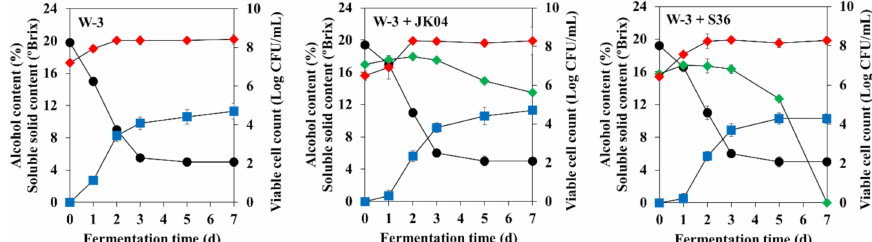
Figure 3. Soluble solids (black circles), alcohol contents (blue squares) and viable cell counts (diamonds) of Muscat Bailey A wine fermented by single culture of Saccharomyces cerevisiae W-3 (W-3), co-culture of S. cerevisiae W-3 and Wickerhamomyces anomalus JK04 (W-3 + JK04), and co-culture of S. cerevisiae W-3 and Metschnikowia pulcherrima S36 (W-3 + S36). Red and green symbols indicate viable cell counts of S. cerevisiae W-3 and non- Saccharomyces yeasts,